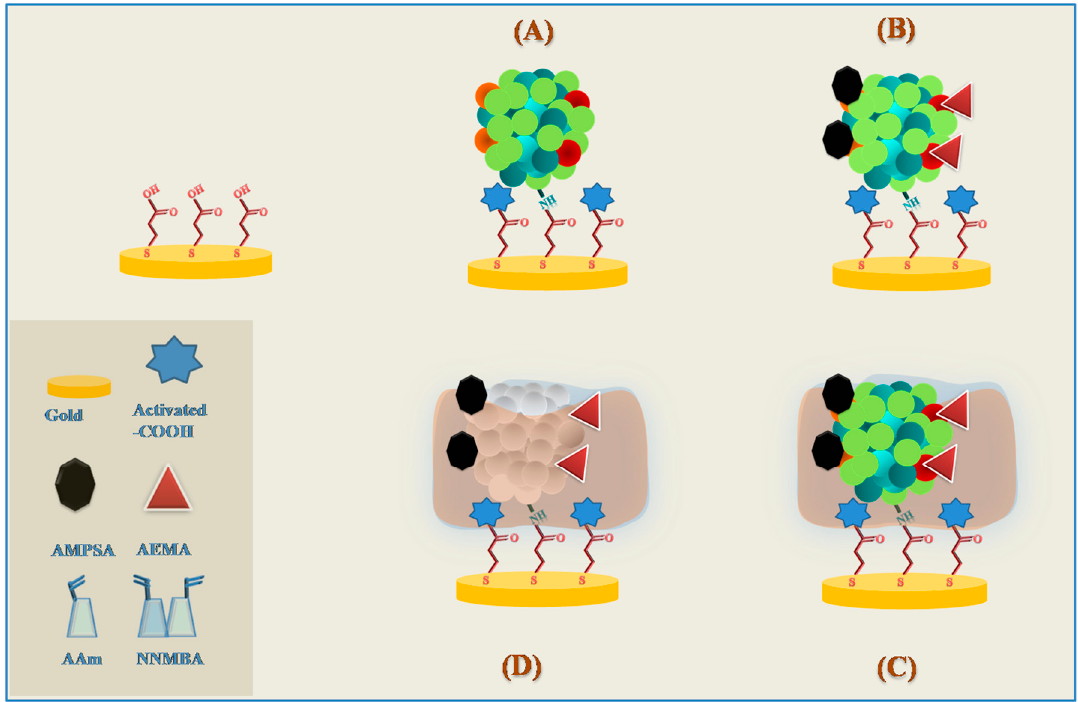
Figure 4. Synthesis of the SPAM material. ( A ) Protein bound; ( B ) Charged labels; ( C ) Polymerization; ( D ) Template removal.